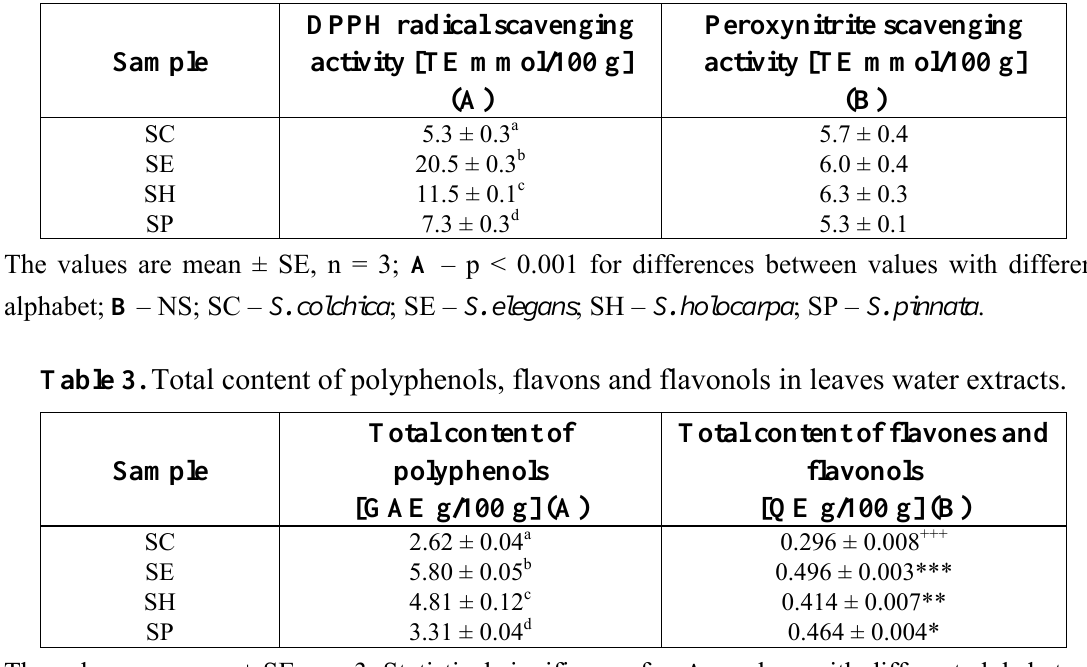
Table 2. Antioxidant activity of leaves water extracts.